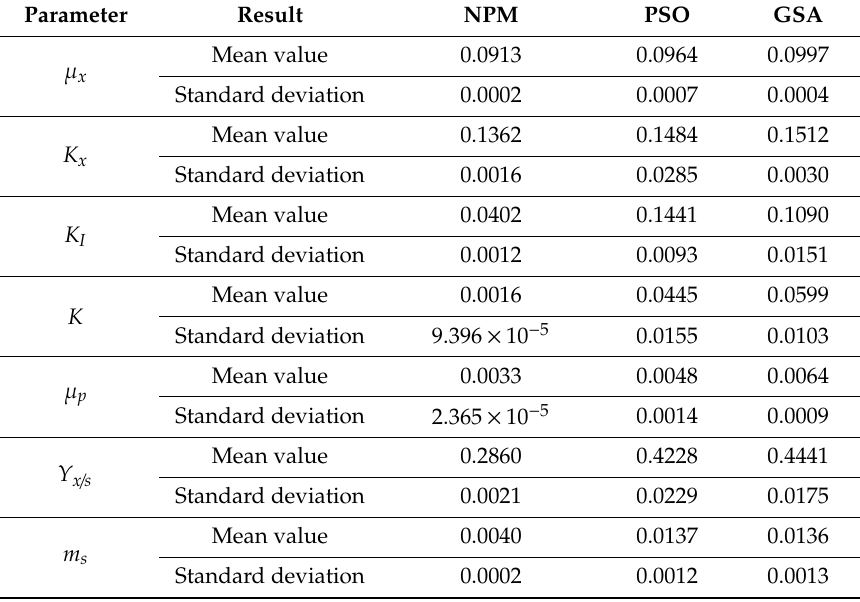
Table 1. Comparison of parameter estimation results for di ff erent